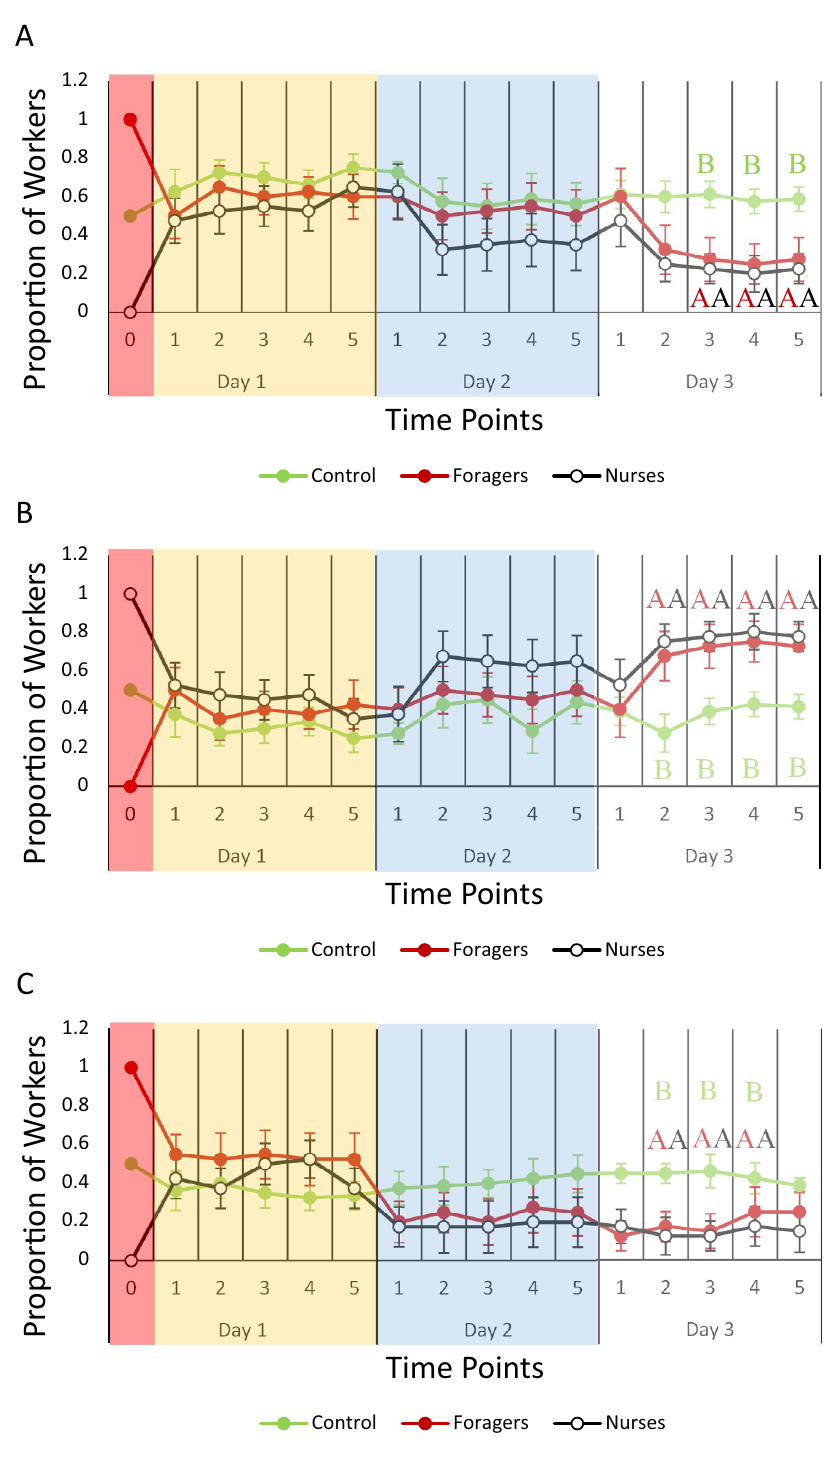
Figure 1. Time point reversion analysis: average proportion (± standard error of the mean) of workers from each treatment group found in different positions within the microcolony during the 48-h observation period. Graphs show the average proportion of workers found ( A ) in the foraging arena and ( B ) in the nest in the presence of eggs; ( C ) in the foraging arena and ( D ) in the nest in the presence of larvae; and ( E ) in the foraging arena and ( F ) in the nest in the presence of pupae. Colored boxes indicate the different days, and each number within each day represents a single observation time point. Time point 0 represents the time before the experiment began, when the type of worker in the micro-colony was manipulated. Different letters indicate statistically significant differences among to each group ( p < 0.05), and colors correspond with each treatment group. Time point 0 was not included in the statistical